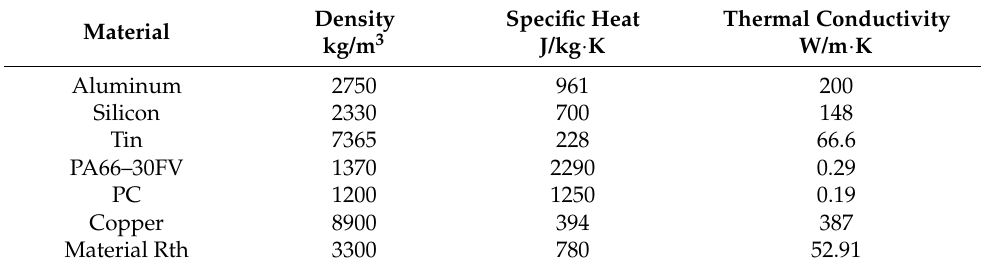
Table 2. Properties of the materials of the model. Source: commercial catalogs of the manufacturer’s Model